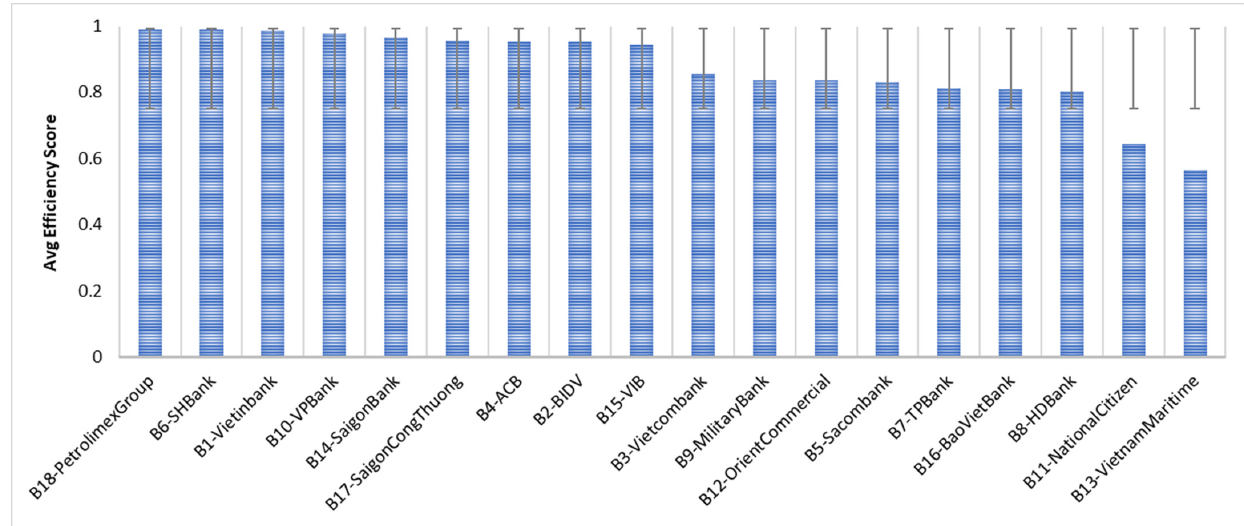
Figure 6. Average efficiency ranking of DMUs (2015–2019).